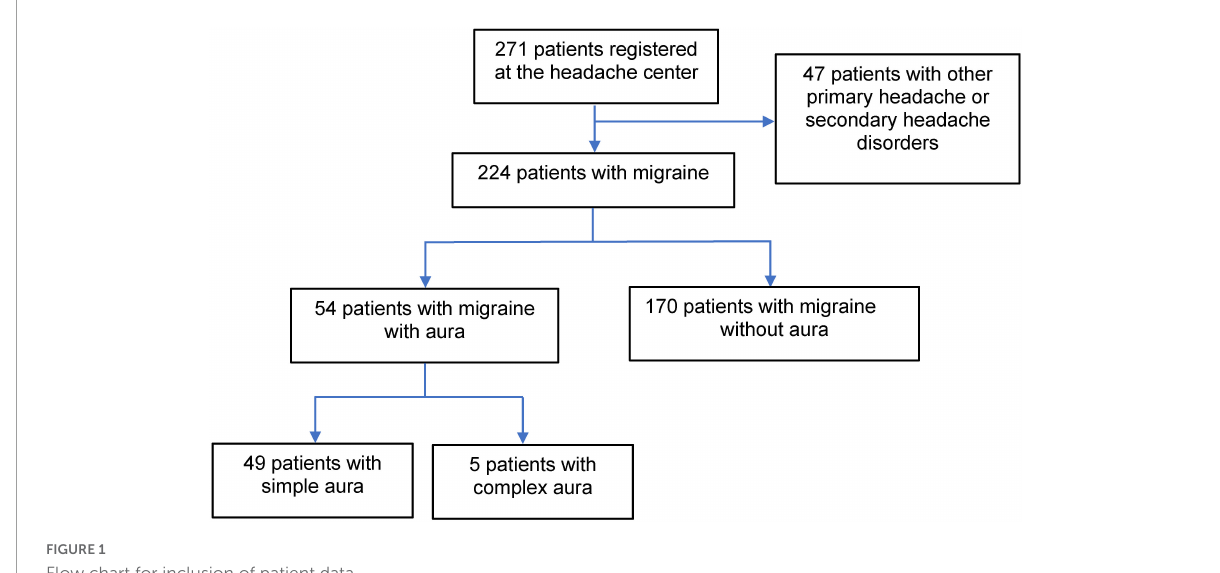
FIGURE1 Flow chart for inclusion of patient data.